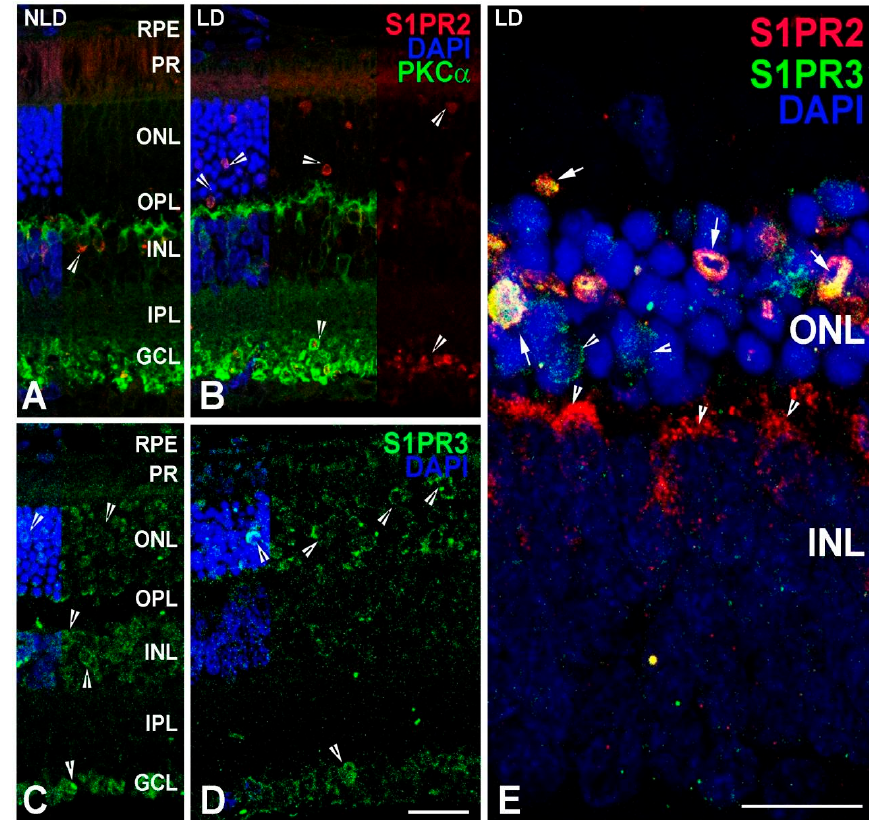
Figure 8. Localization of S1PR2, S1PR3 and PKC α in light damaged (LD) and non-light damaged (NLD) adult (2–4 months old) rat retinal tissues. ( A ) Retinal section of NLD SD rat eye with S1PR2 localization in different layers shown by arrowheads. ( B ) Retinal section of LD SD rat eye with S1PR2 localization in different layers shown by arrowheads. ( C ) Retinal section of NLD SD rat eye with S1PR3 localization in different layers shown by arrowheads. ( D ) Retinal section of LD SD rat eye with S1PR3 localization in different layers shown by arrowheads. ( E ) Magnified view of LD SD rat eye showing localization of S1PR2 and S1PR3 in the ONL and INL with arrowheads. RPE, retinal pigment epithelium. PR, photoreceptor. ONL, outer nuclear layer. OPL, outer plexiform layer. INL, inner nuclear layer. IPL, inner plexiform layer. GCL, ganglion cell layer. Scale = 25 µm.